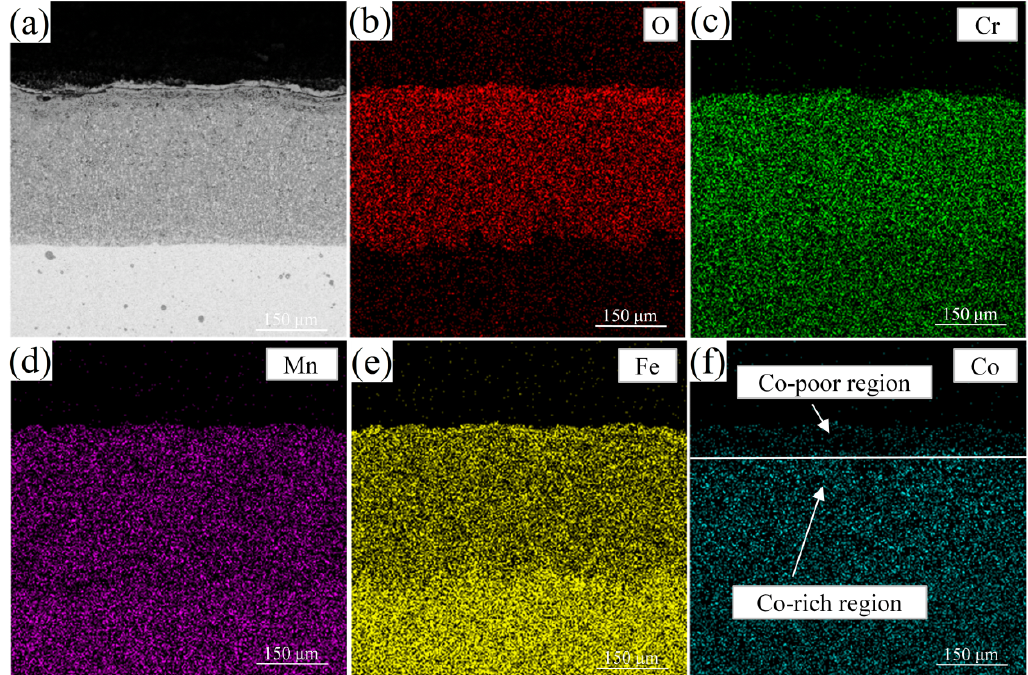
Figure 6. EDS results of Cr-Mn-Fe-Co HEA after isothermal oxidation tests at 900 °C for 48 h. The instantaneous rate constant K p decreased with the incremental oxidation time.